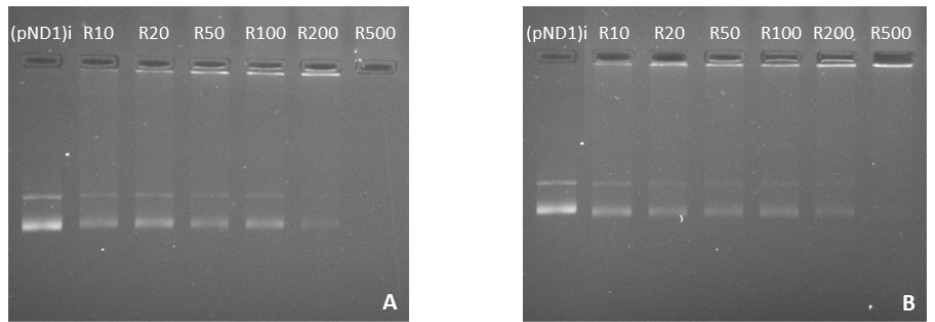
Figure 5. Agarose gel electrophoresis of the initial pND1 solution ((pND1)i) and supernatants resulting from the formulation of PEI–DQA (10 kDa)/TAT/pND1 systems (PEI–DQA N/P = 10, 20, 50, 100, 200, and 500, and TAT N/P = 1) ( A ) and PEI–DQA (25 kDa)/TAT/pND1 systems (PEI–DQA N/P = 10, 20, 50, 100, 200, and 500, and TAT N/P = 1) ( B ).